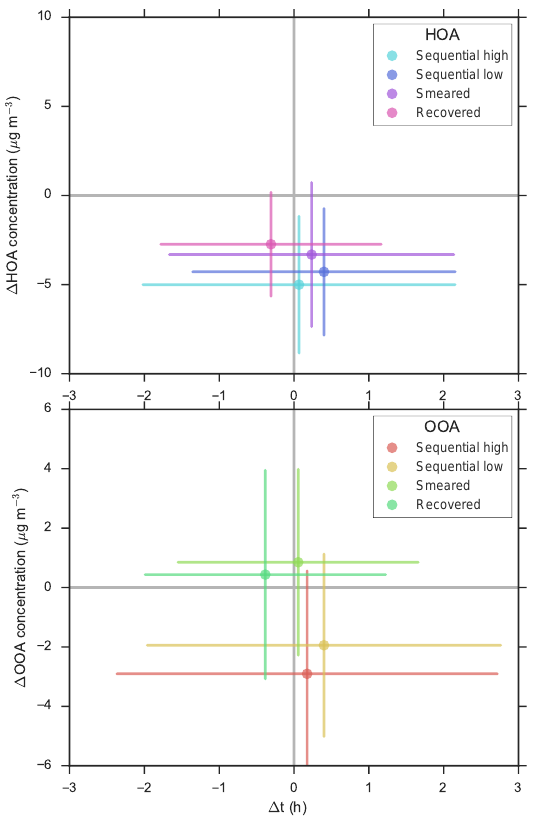
Figure 11. Peak plots for time series of period 57h measured with 4h samples subject to 20% measurement uncertainty processed by the sequential, smeared and recovered methods. The “sequen- tial high” and “sequential low” time series are constructed by lin- ear interpolation between suboptimally and optimally scheduled se- quential measurements, respectively. The recovered solutions were obtained with TSVD regularization and the truncated boundary method. The peak plots are explained fully in the main text in Sect.